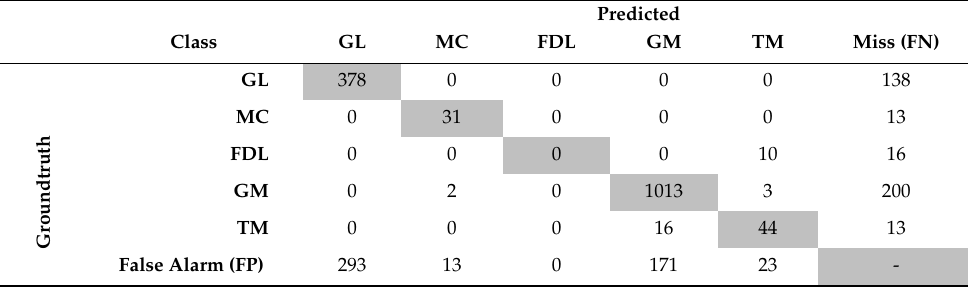
Table 9. Confusion matrix for final SSD ResNet50 model on the test set, using a score threshold of 0.05 and 0.1 NMS